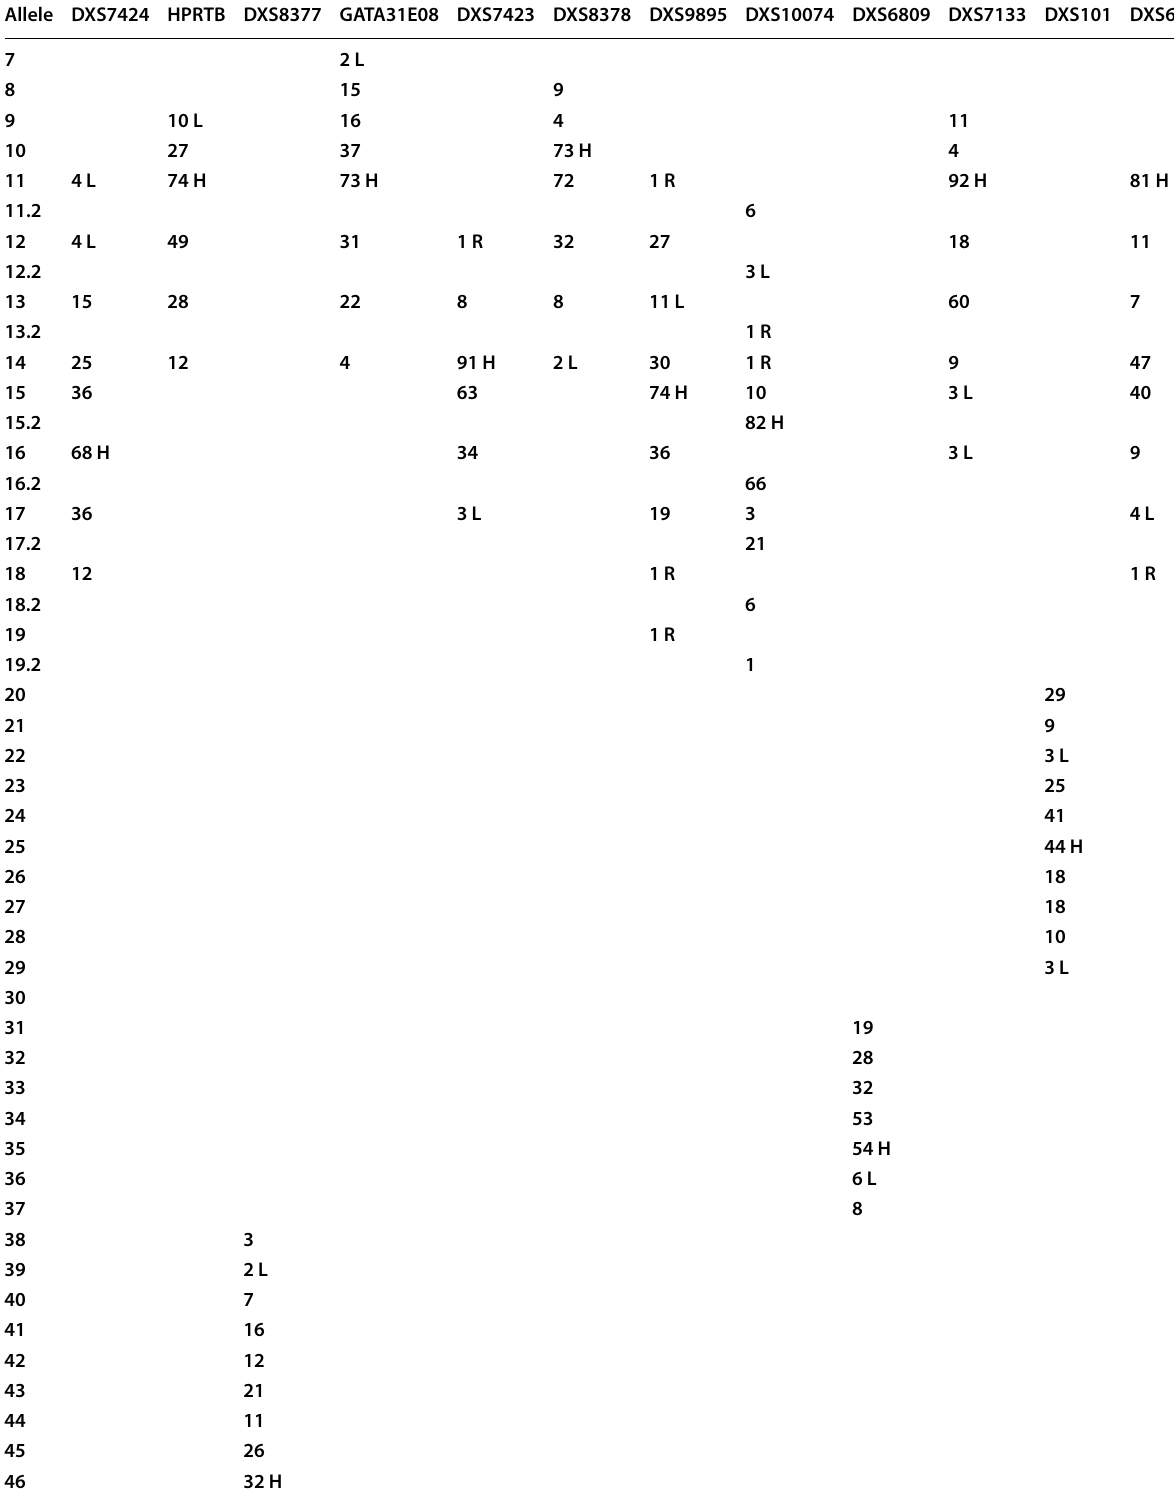
Table 4 The allele occurrence for the 200 unrelated Arabic Iraqi male